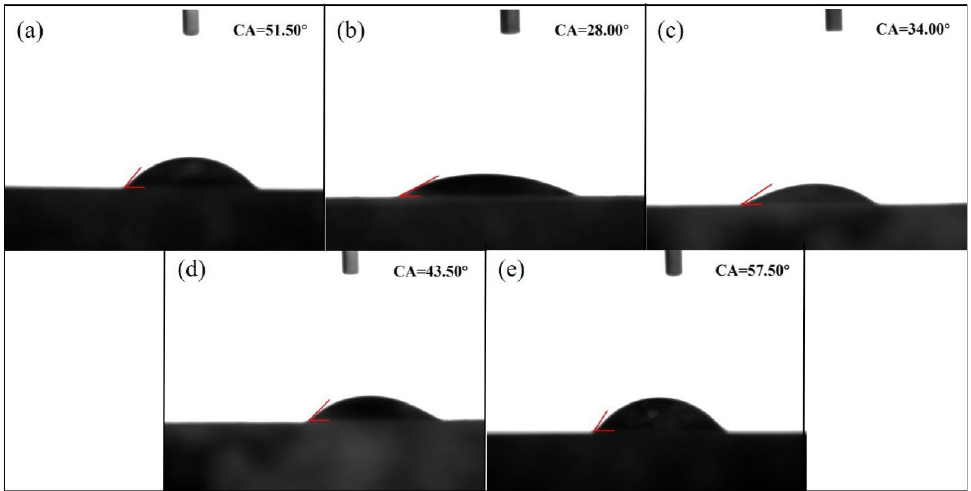
Figure 10. Contact angle of water with aggregates: ( a ) limestone; ( b ) diorite; ( c ) diabase; ( d ) SSA; ( e ) PSSA. Table 6. Surface free energy of bitumen and probe liquid (mJ/m 2 ). Table 7. Adhesion work and stripping work of various aggregates and bitumen (mJ/m 2